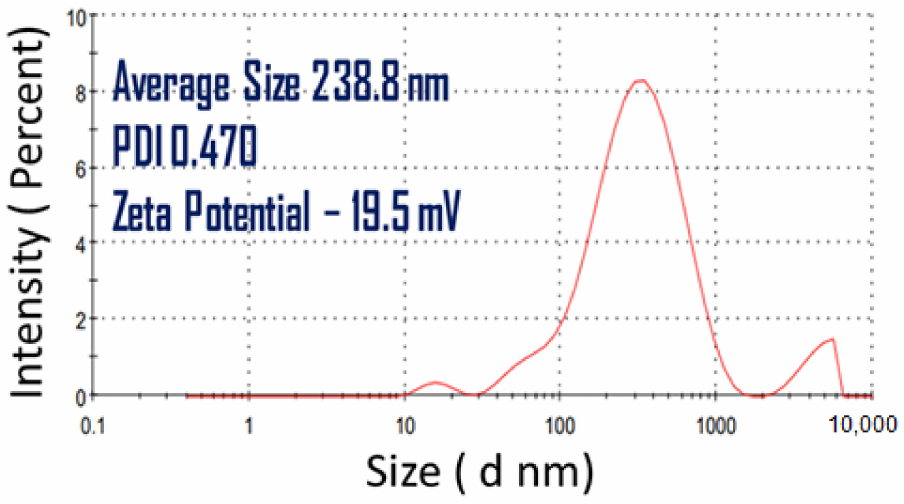
Figure 8. DLS size of Ag-based NPs that are prepared by using